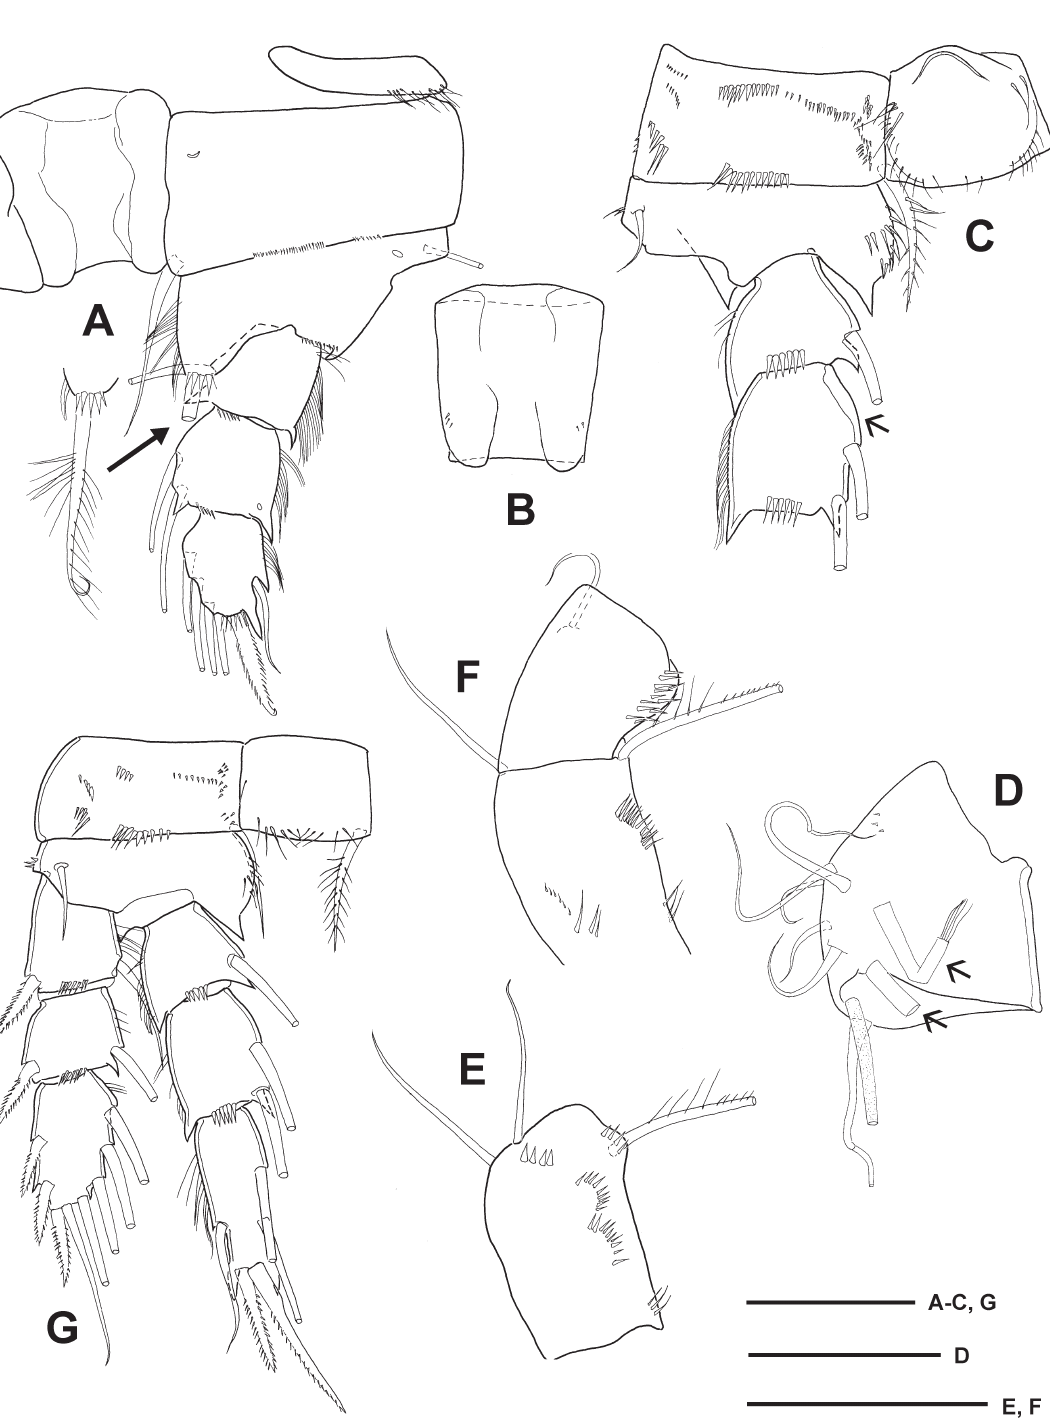
Fig. 4. Eucyclops azorensis Defaye & Dussart, 1991 (Azores, paratypes; MNHN Cp. 611). A−C . ♀. D−G . ♂. A . Leg 1, frontal view − medial seta of basipodite is figured separately. B . Leg 1 intercoxal sclerite, frontal view. C . Leg 4, protopodite and first and second endopodal segments, caudal view – note thickened cuticle in inner proximal margin of second endopodite (arrow). D . First antennulary segment with two modified brush setae (arrows) and one aesthetasc (shaded), ventral view. E . Antennal coxobasis, caudal view. F . Antennal coxobasis and first endopodal segment, frontal view. G . Leg 4, caudal view. A shows ♀-2; B−C show ♀-1; D−G show ♂-1. Scale bars: A−G = 50